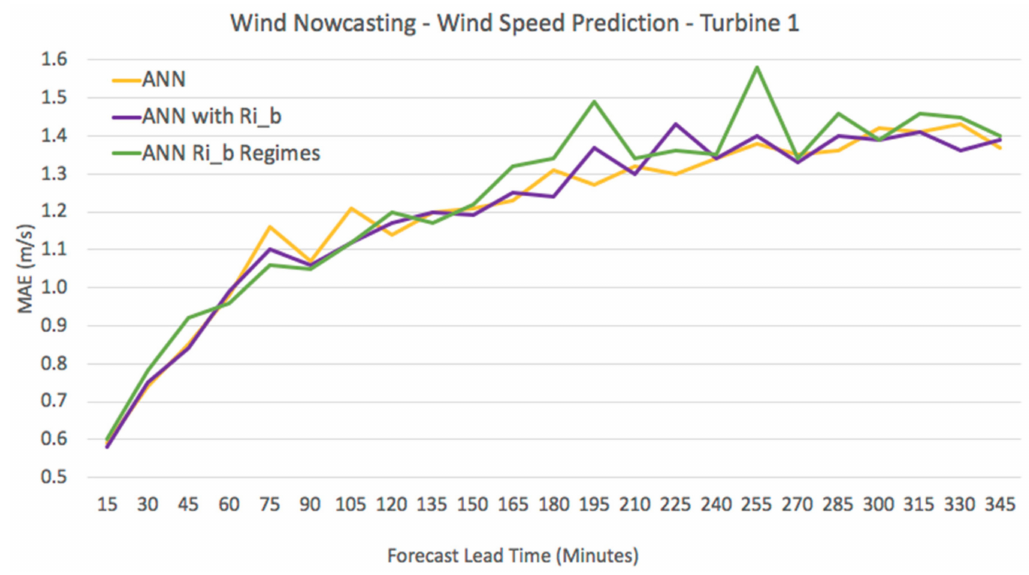
Figure7. Results(MAE)fortheartificialneuralnetworks(ANN)(goldline)comparedtostability-regime dependent ANNs separated by unstable ( − ) and stable ( + ) regimes (green line) compared to the ANNs trained with bulk Richardson number (Ri B ) as a predictor (purple